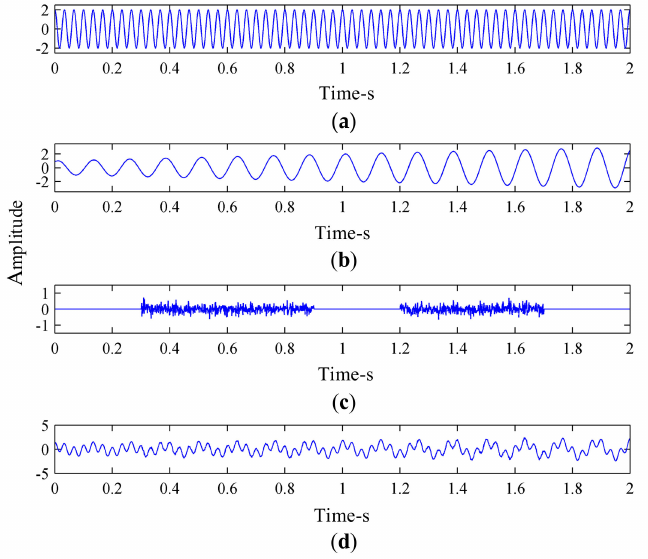
Figure 6. Time-domain diagram of the synthesized signal and its components: ( a ) Sine signal x 1 ( t ); ( b ) Amplitude modulation signal x 2 ( t ); ( c ) Intermittent random signals n ( t ); and ( d ) Synthetic simulation signal x ( t ).